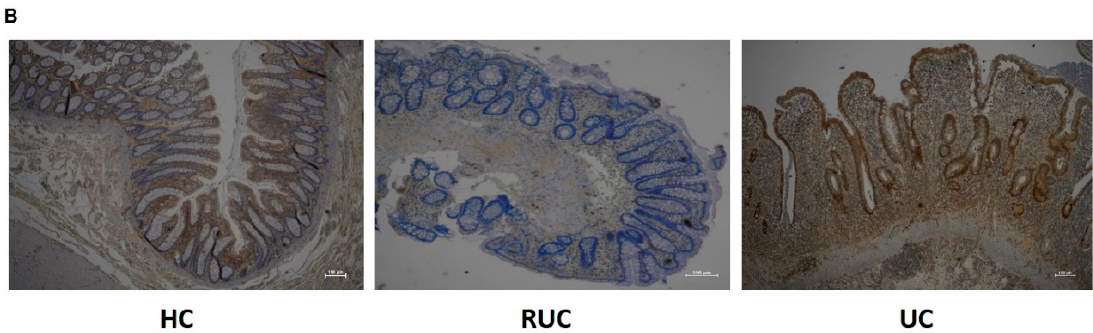
Figure 6. PSMB9 expression in IBD patients. ( A ) Analysis of colonic tissue from IBD patients and controls downloaded from the GEO database (GSE6731). Mean expression data were expressed as log of expression values. ( B ) PSMB9 protein expression at IHC in formalin-fixed, paraffin-embedded tissues obtained from healthy controls (HC), remission UC (RUC) patients and active ulcerative colitis (UC) patients. Original magnification, × 4. Scale bar presents 100 µ m. *** p < 0.0001.